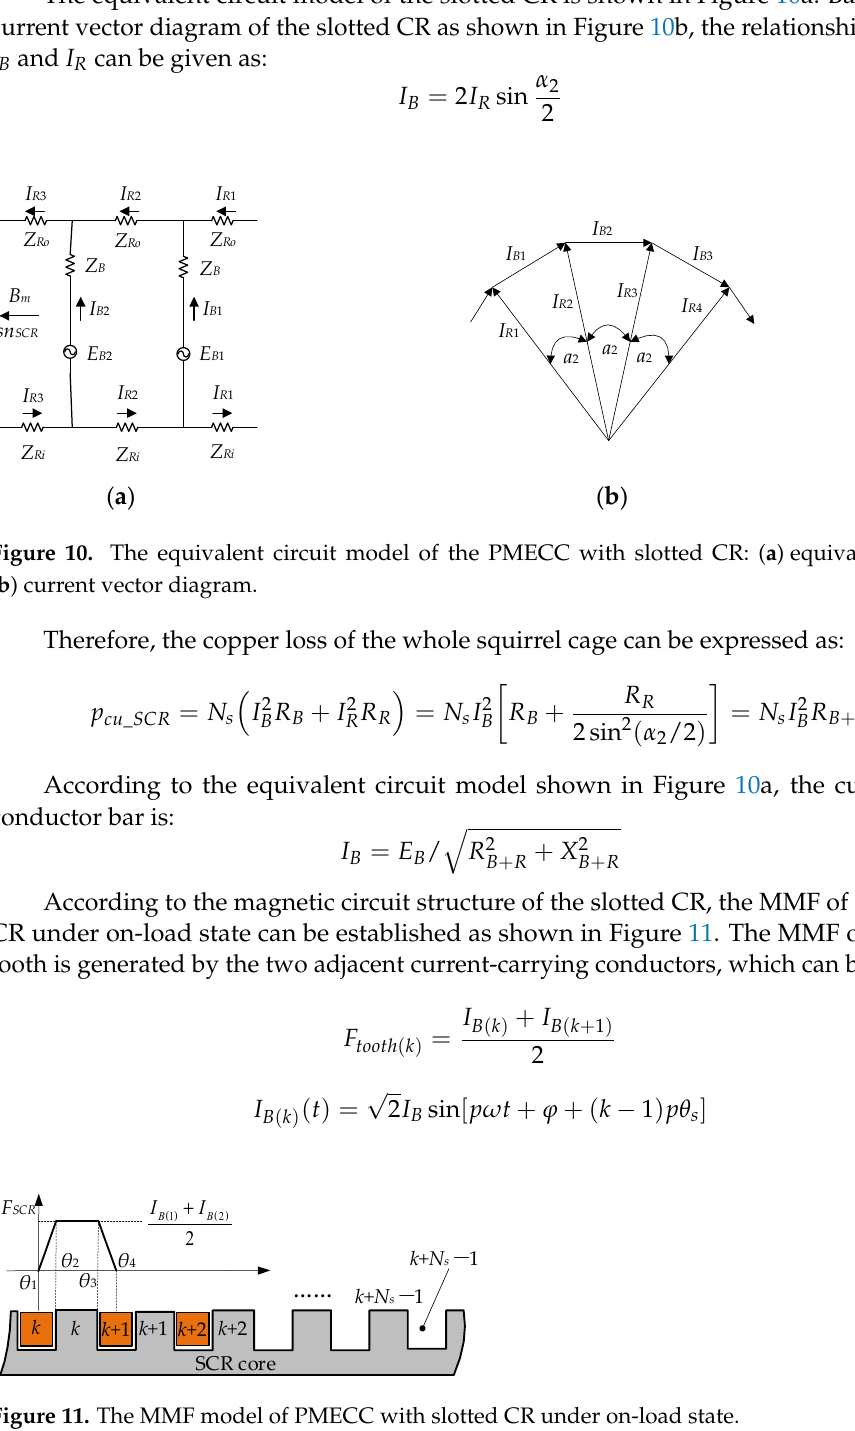
Figure 11. The MMF model of PMECC with slotted CR under on-load